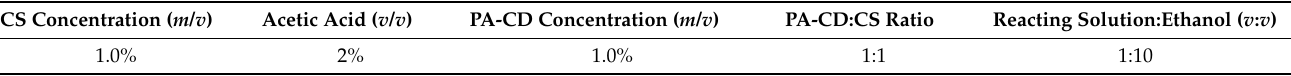
Table 1. Preparation of CS-PA-CD